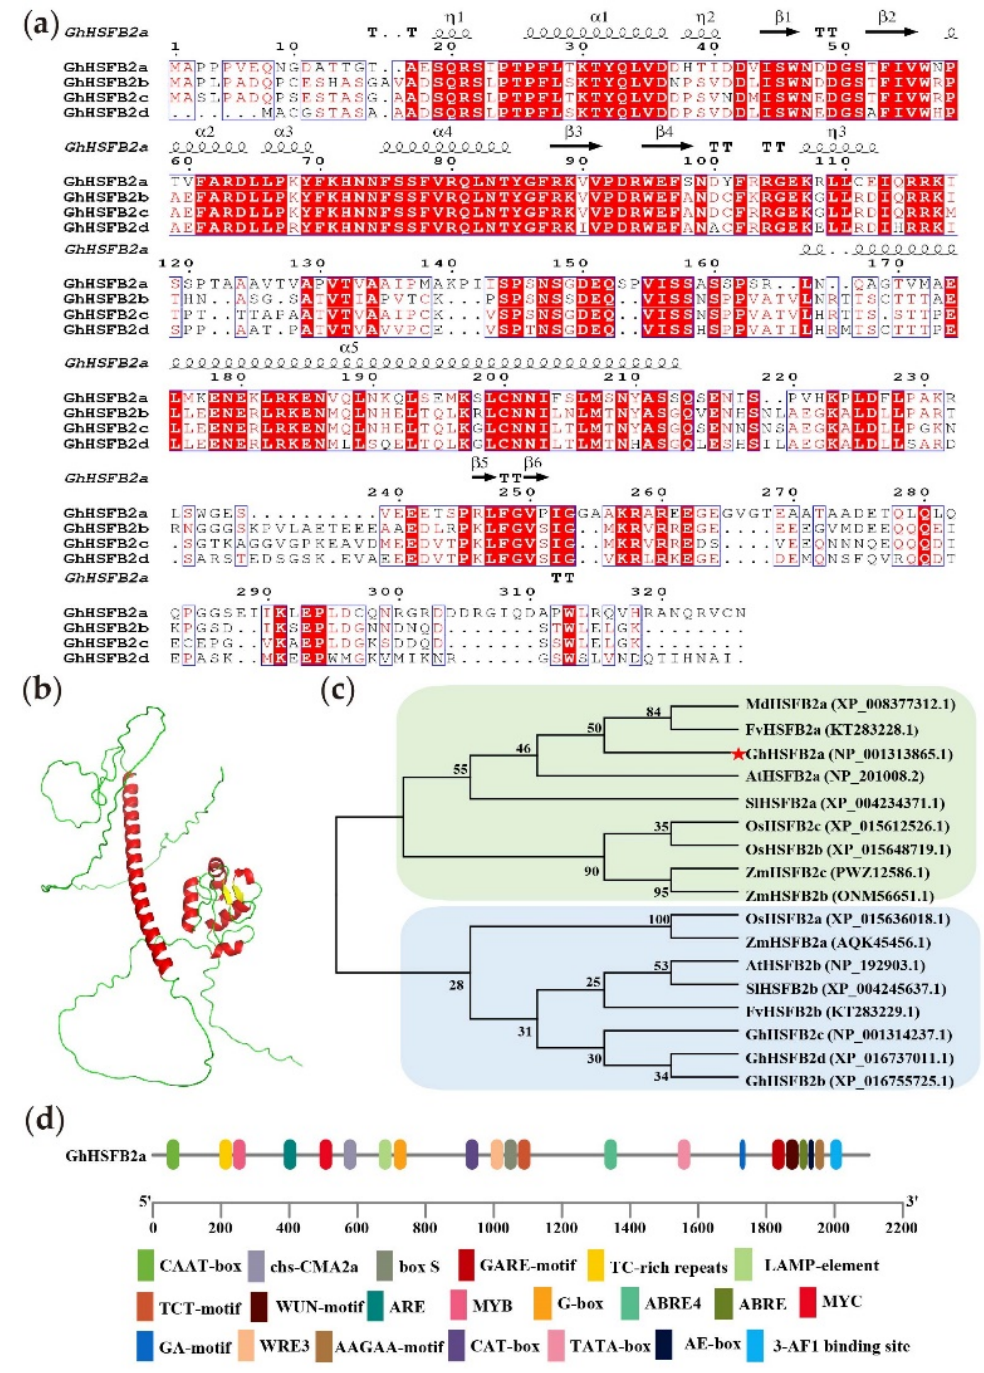
Figure 1. Structural characteristics of GhHSFB2a . ( a ) Multiple sequence alignment of GhHSFB2a, GhHSFB2b, GhHSFB2c, and GhHSFB2d proteins. The common residues of the four sequences are displayed in white letters on a red square, and similar residues are shown in red. The black dot represents a single-amino-acid deletion, and the black arrow and coiled helix represent the predicted secondary structure. ( b ) Three-dimensional GhHSFB2a model. ( c ) Phylogenetic tree analysis of HSFB2 proteins from Gossypium hirsutum (Gh), Solanum lycopersicum (SI), Arabidopsis thaliana (At), Fragaria vesca (Fv), Malus domestica (Md), Oryza sativa (Os), Zea mays (Zm). ( d ) Cis-acting element analysis of GhHSFB2a promoter